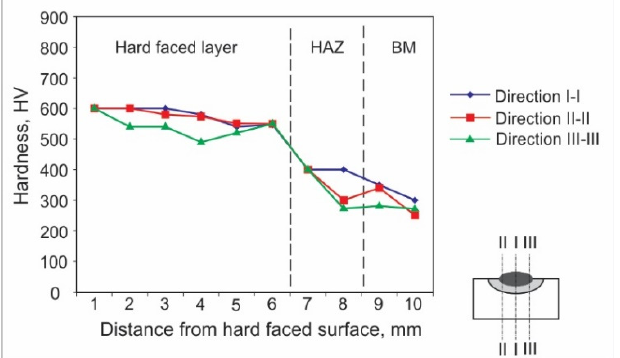
Figure 4. Hardness distribution in the hard-faced layer cross-section, BM-42CrMo4, FM-E DUR 600.